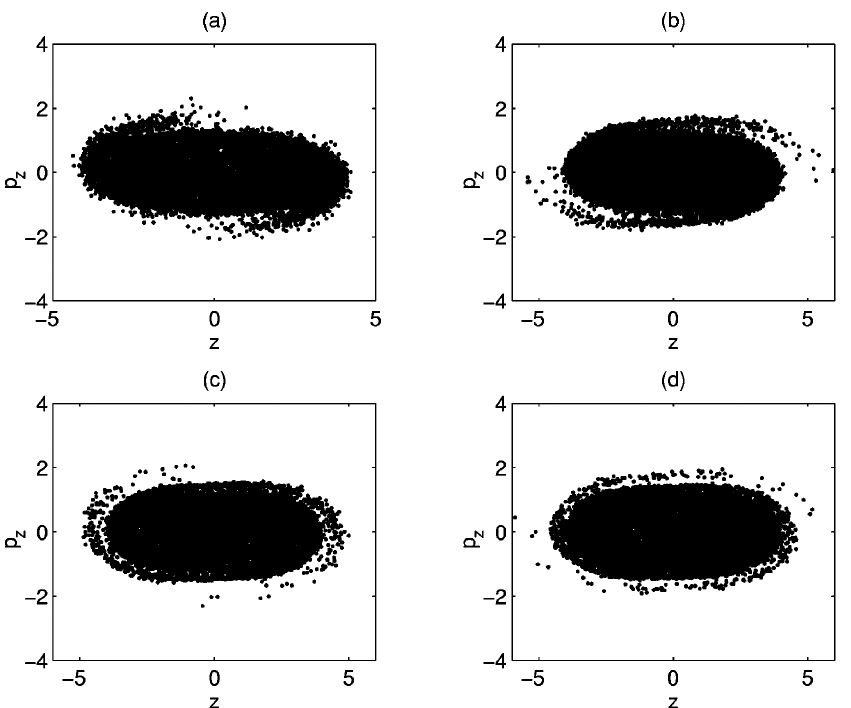
FIG. 5. Longitudinal phase space diagram at different time steps of initially matched beam m (cid:120) (cid:173) m (cid:121) (cid:173) m (cid:122) (cid:173) (cid:49)(cid:46)(cid:48) with 6D Gaussian distribution ( (cid:99) (cid:121) (cid:97) (cid:173) (cid:51)(cid:44) h (cid:120) (cid:173) (cid:48)(cid:46)(cid:55)(cid:53)(cid:44) h (cid:122) (cid:173) (cid:48)(cid:46)(cid:54)(cid:53) ): (a) (cid:116) (cid:173) (cid:53)(cid:48) , (b) (cid:116) (cid:173) (cid:49)(cid:48)(cid:48) , (c) (cid:116) (cid:173) (cid:49)(cid:53)(cid:48) , and (d) (cid:116) (cid:173) (cid:50)(cid:48)(cid:48) .